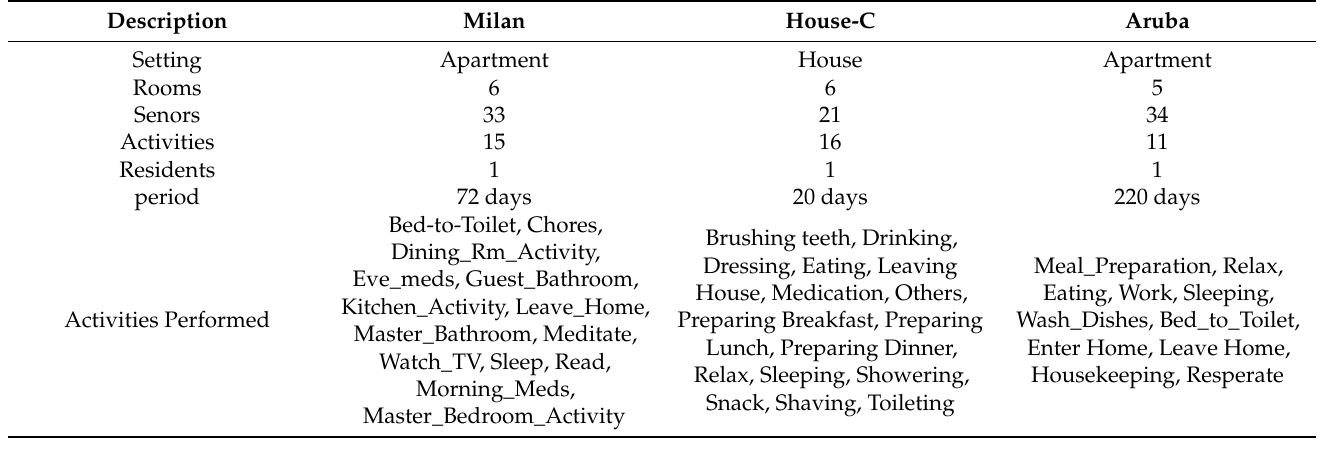
Table 1. Outlines of Datasets.